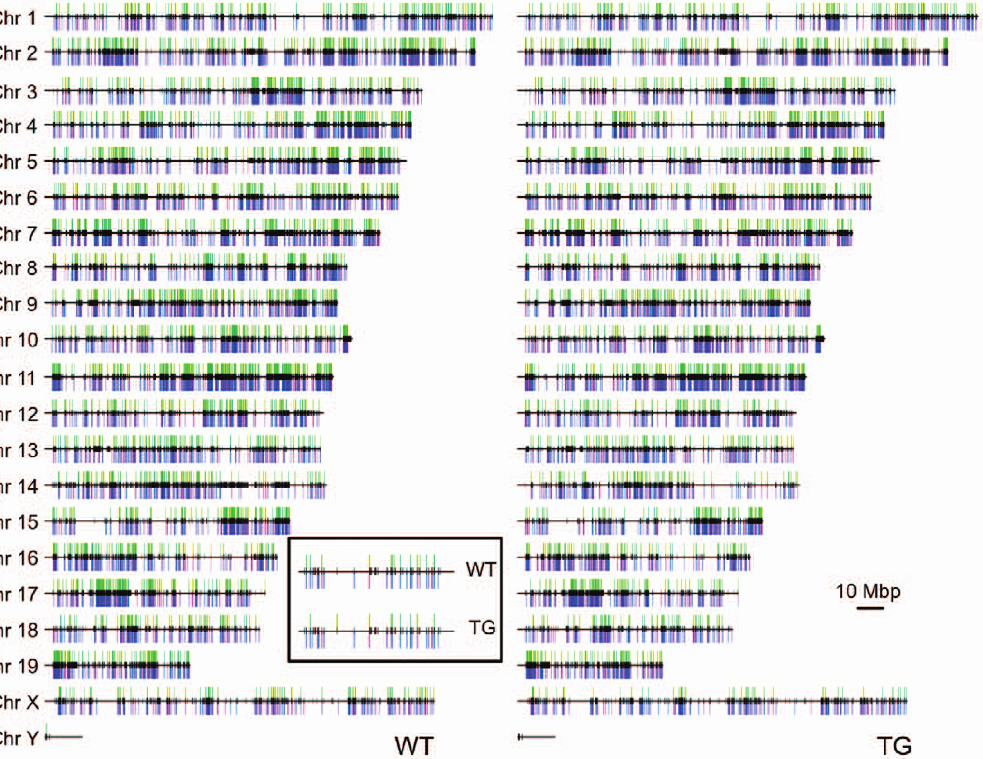
Figure 3. AcH3-gene associations are distributed across the genome and correlate with expressed genes. Localization of AcH3-gene interactions (green) along each chromosome and are co-localized with steady-state gene expression (blue) in WT (left) and TG striata (right). Horizontal black line, length of chromosome; Vertical black lines, locations of genes. Inset, a closer view of Chromosome 1 from 90574275 bp– 93452450 bp.